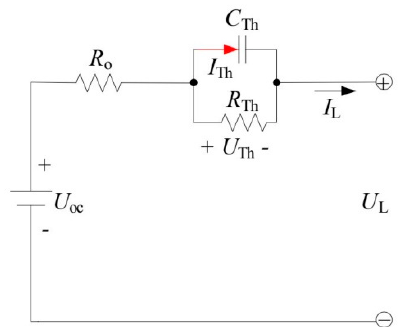
Figure 1. First-order Thevenin model.